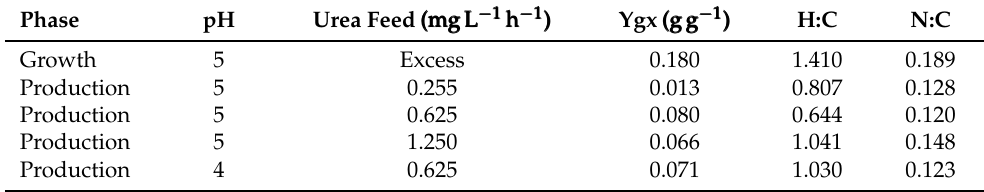
Figure 4. The effect of pH and urea addition on the yield of biomass on glucose. As indicated in Table 1, repeat experiments were conducted, and the average values of the two experiments are presented. For the conditions that were not repeated, single fermentation values were used. Table 2. Experimental parameters analysing the yield and elemental composition of R. oryzae biomass.